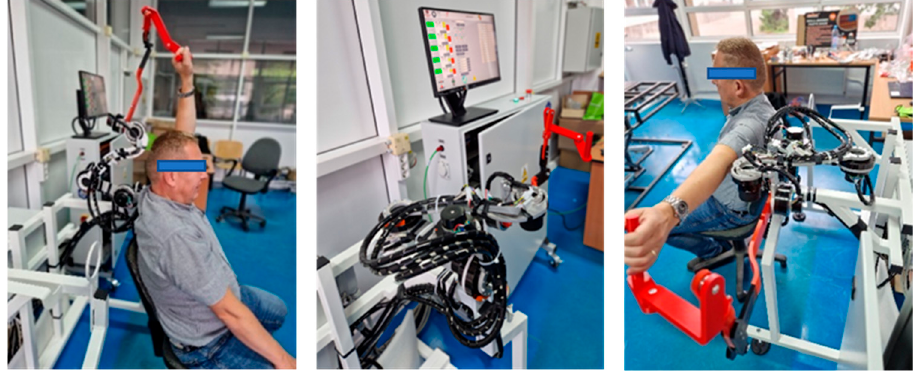
Figure 11. CardioVR-ReTone robotic exoskeleton prototype (TRL4) tested in a